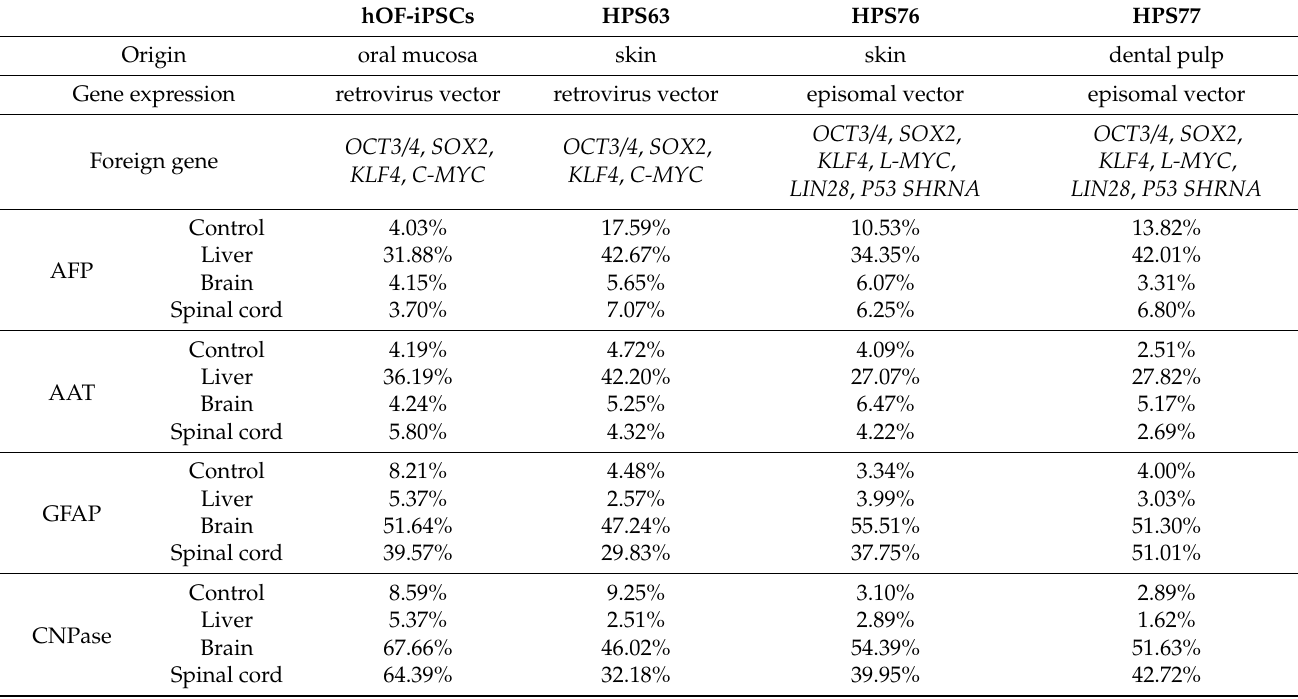
Table 1. Characteristics of the iPSCs used and their efficiency of